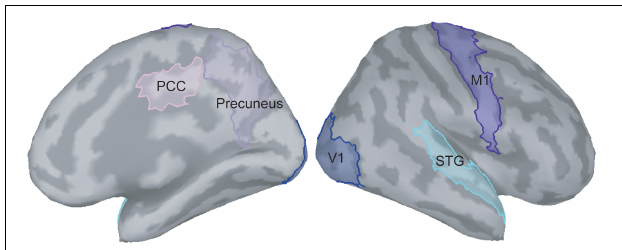
FIGURE 2 | Selection of regions of interest on the ICBM152 cortical surface. PCC, posterior cingulate cortex; V1, primary visual cortex; M1, primary motor cortex; STG, superior temporal